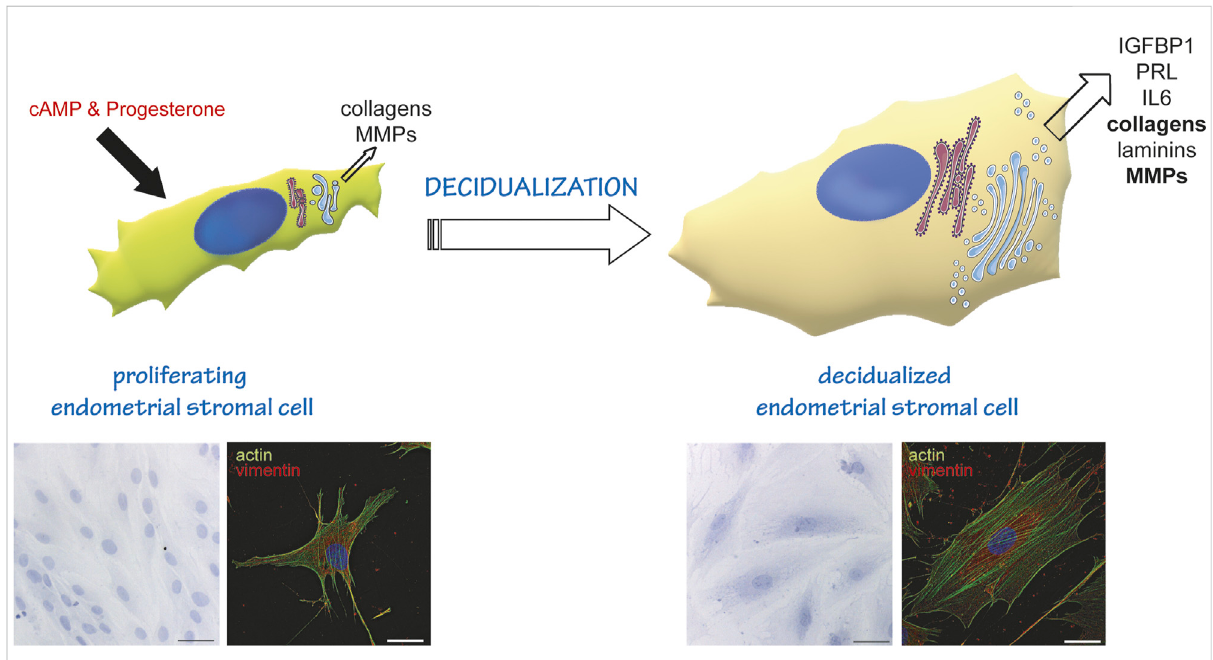
FIGURE 1 Endometrial stromal cells as a model ofcell differentiation to asecretory phenotype. In the proliferative state, EnSC show a fi broblastoid shape, and produce and secrete some collagens and metalloproteases (MMPs). Decidualisation (induced in vitro by cAMP and Progesterone stimulation) induces a reshaping of the entire cell and of the secretory compartment. Cells stop proliferating and enlarge, acquiring an epithelioid-like shape. They enlarge their ER and Golgi compartment (Anelli et al., 2021) and transform into professional secretors, expressing and secreting decidualization markers (IGFBP1, PRL,IL6), more and differentcollagens, MMPs and laminins.The lower insets on theleftshow aHematoxylin-Eosin staining of cells at day 0 (proliferating, left) and day 6 of decidualization (right). Images were acquired with a ×20 objective; bar: 60 µm. The lower insets on the right show an immuno fl uorescence of proliferating (left) and decidualized cells (right) stained with fl uorescently labelled Phalloidin (actin, green) and anti-vimentin antibody (red). Note the change in cytoskeletal reorganization following stimulation. Images were acquired with a ×60 objective; bar: 20